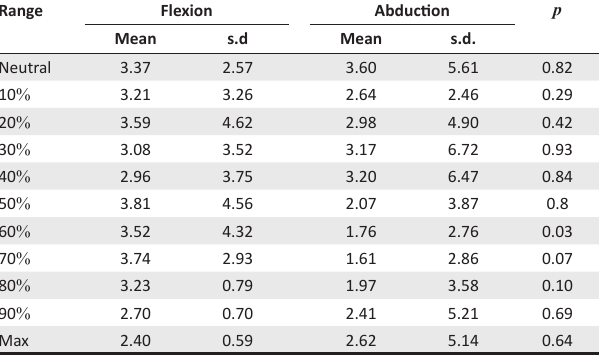
TABLE 2: A comparison between the electromyographic mean muscle activity ratios ( n = 16). Range Flexion